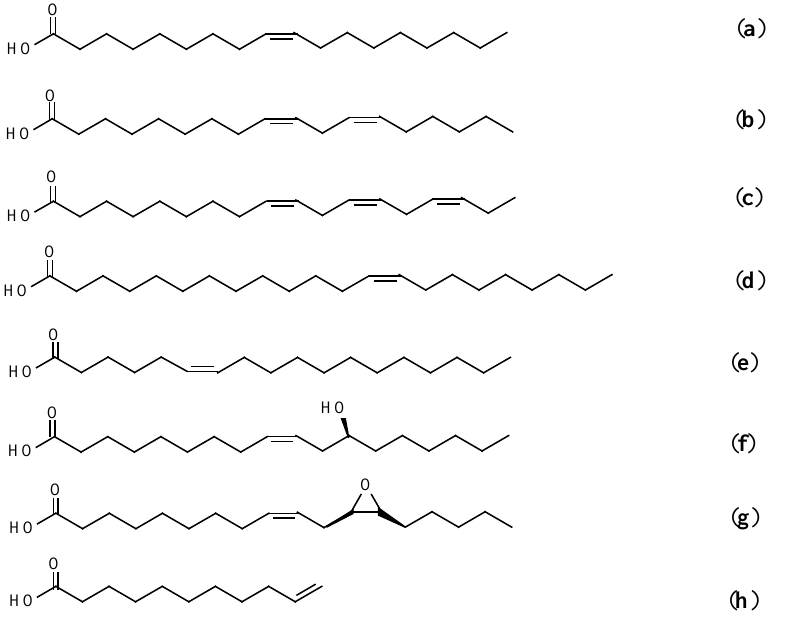
Figure 2. Commonly used fatty acids for the synthesis of renewable platform chemicals ( a ) oleic acid ( b ) linoleic acid ( c ) linolenic acid ( d ) erucic acid ( e ) petroselinic acid ( f ) ricinoleic acid ( g ) vernolic acid ( h ) 10-undecenoic acid.